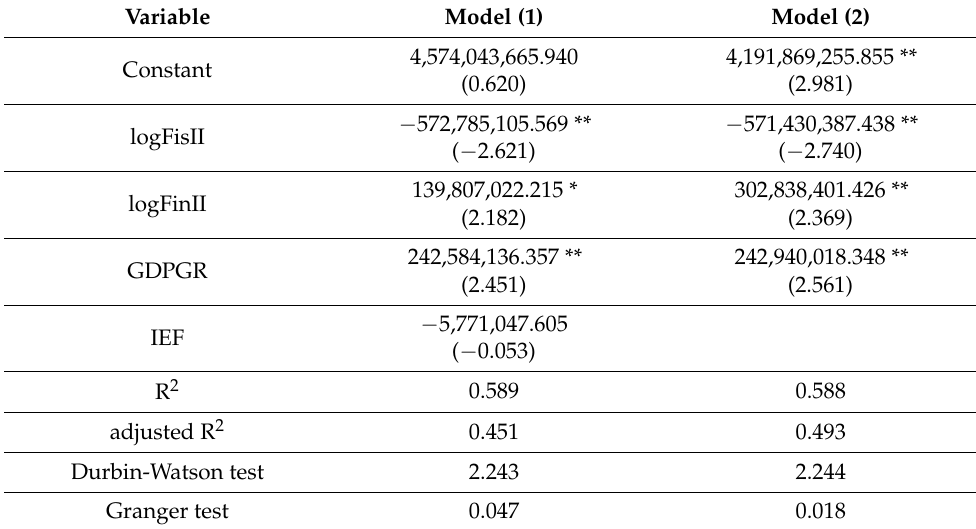
Table 3. Regression results of models (1)–(2).